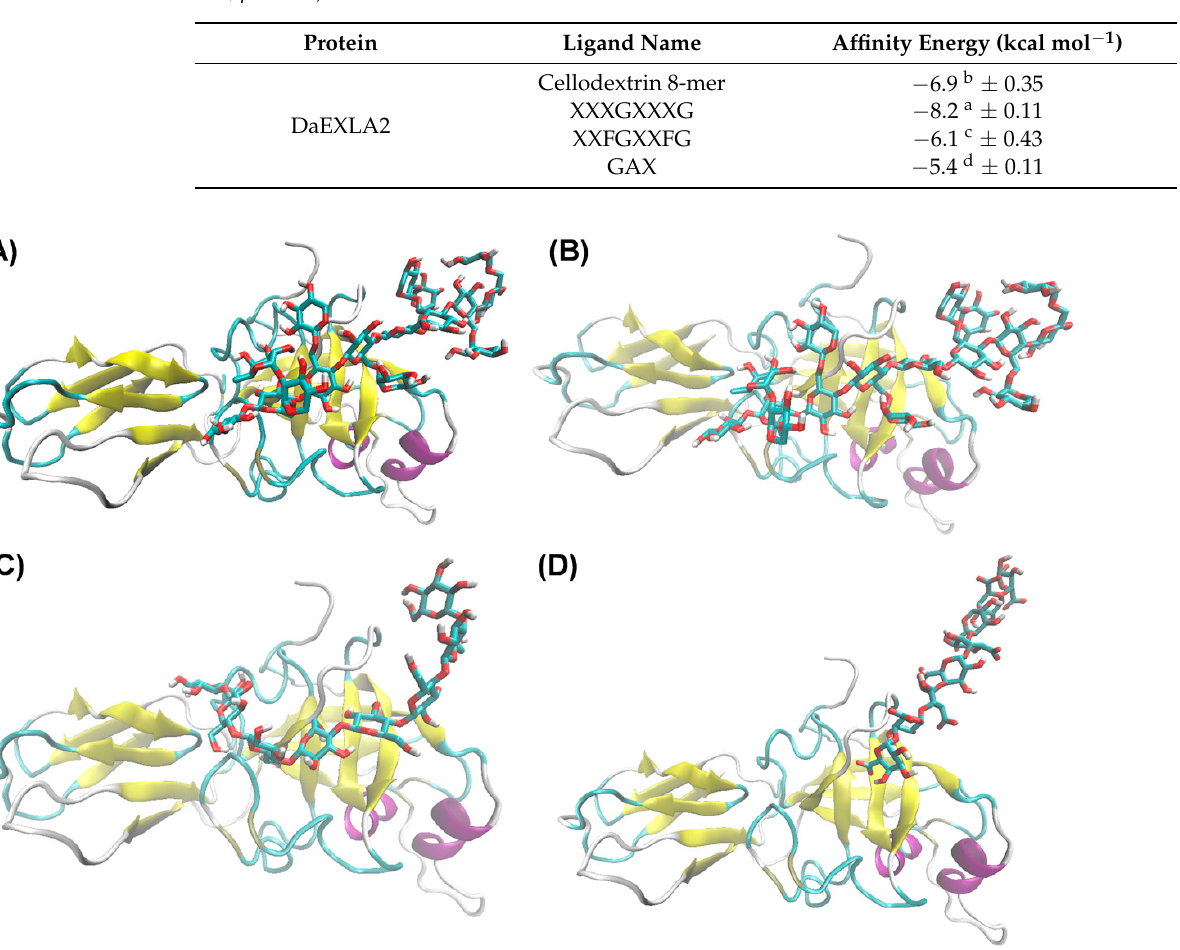
Table 3. Affinity energy calculated mediating molecular docking methodology. Superscript letters indicate significant differences between the different ligands tested with each protein (Tukey HSD test, p < 0.05).